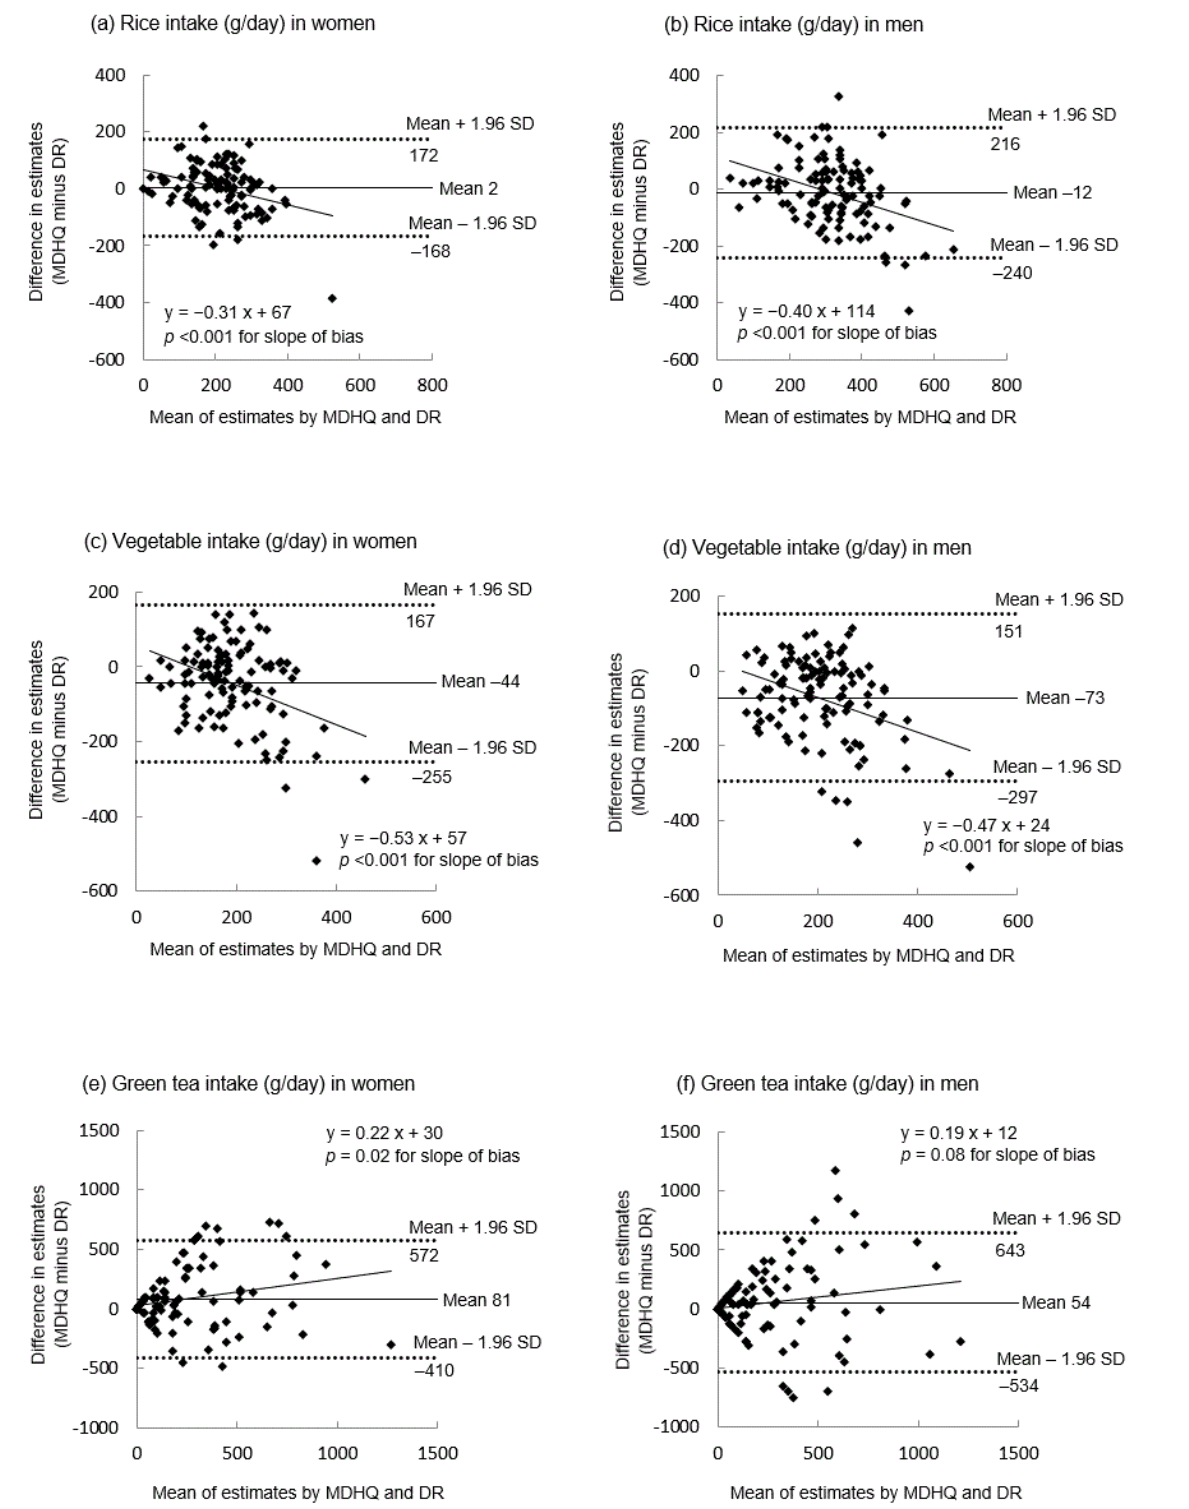
Figure 2. Bland – Altman plots assessing the agreement between estimates of overall intakes of rice ( a , b ), vegetables ( c , d ), and green tea ( e , f ) derived from the 4-day weighed dietary record (DR) and those derived from the web version of the Meal-based Diet History Questionnaire (MDHQ) in 111 Japanese women and 111 Japanese men. SD, standard deviation.